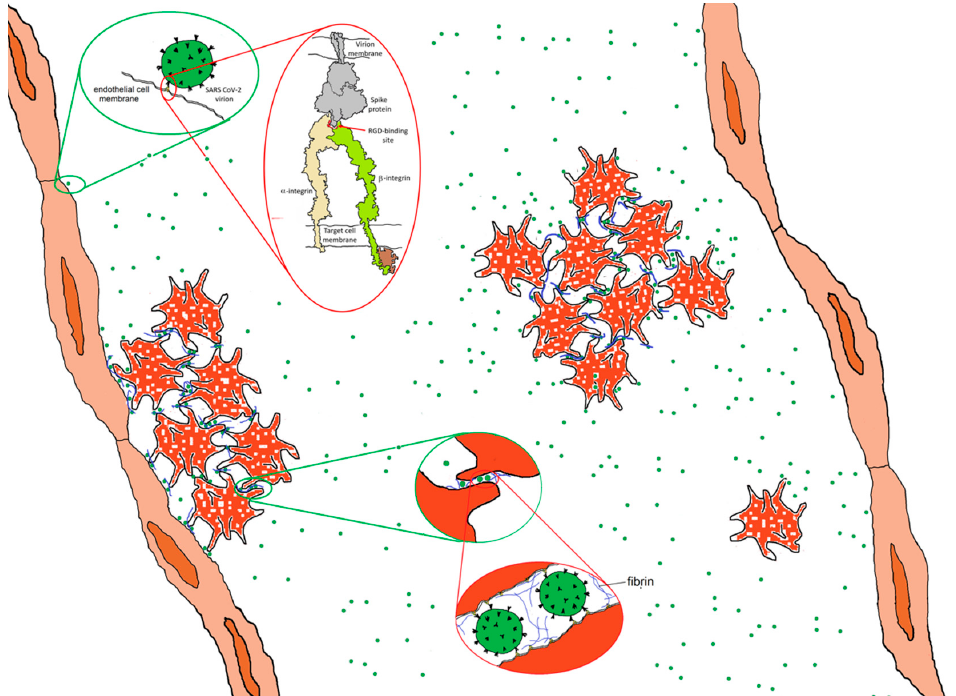
Figure 8. Hypothetical adhesive impact of the interaction of SARS CoV-2 spike protein to integrins. Spike protein interacting with an activated integrin molecule (top inset) provides a mechanism for adhering to endothelial cells and, potentially, platelets, contributing with fibrin to platelet adhesiveness and aggregation (bottom inset). Integrin drawing based on PDB Molecule of the Month: https://pdb101.rcsb.org/motm/134.